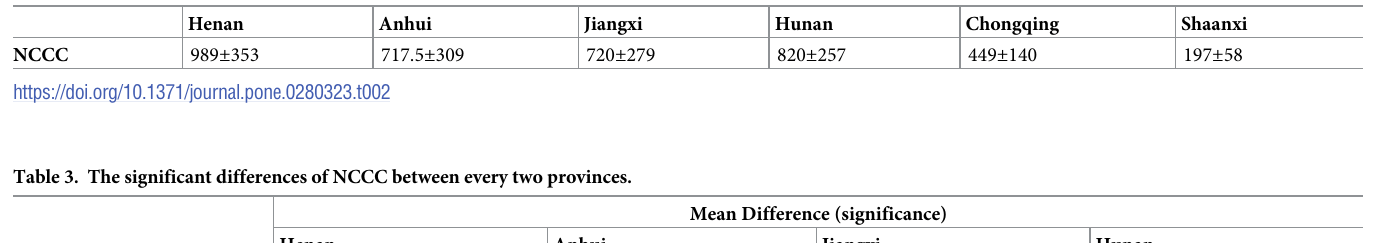
Table 2. The mean value and standard deviation of NCCC in six provinces for four weeks.